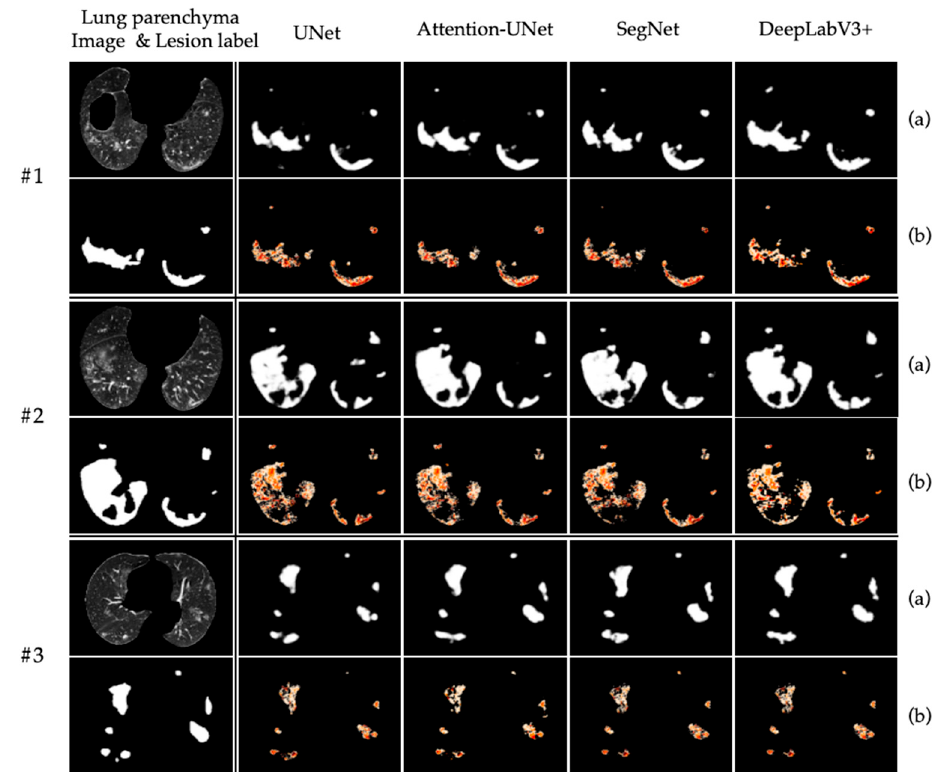
Figure 5. Visualization of the lesion segmentation using original label and refined hierarchical label. ( a ) and ( b ) illustrate the segmentation results using original lesion labels and refined hierarchical labels, respectively.